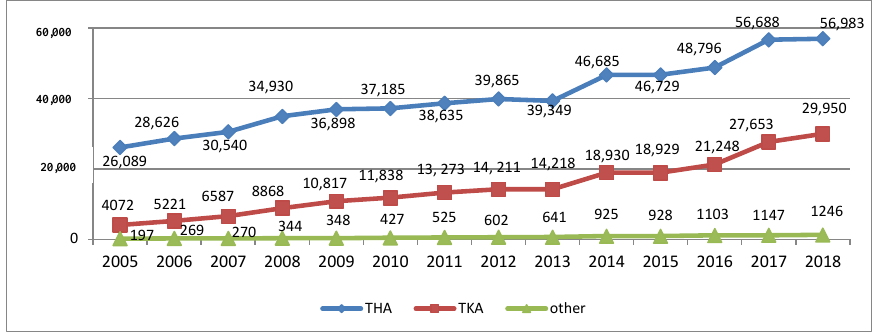
Figure 2. Number of individual types of joint replacement surgeries performed in Poland in 2005–2018